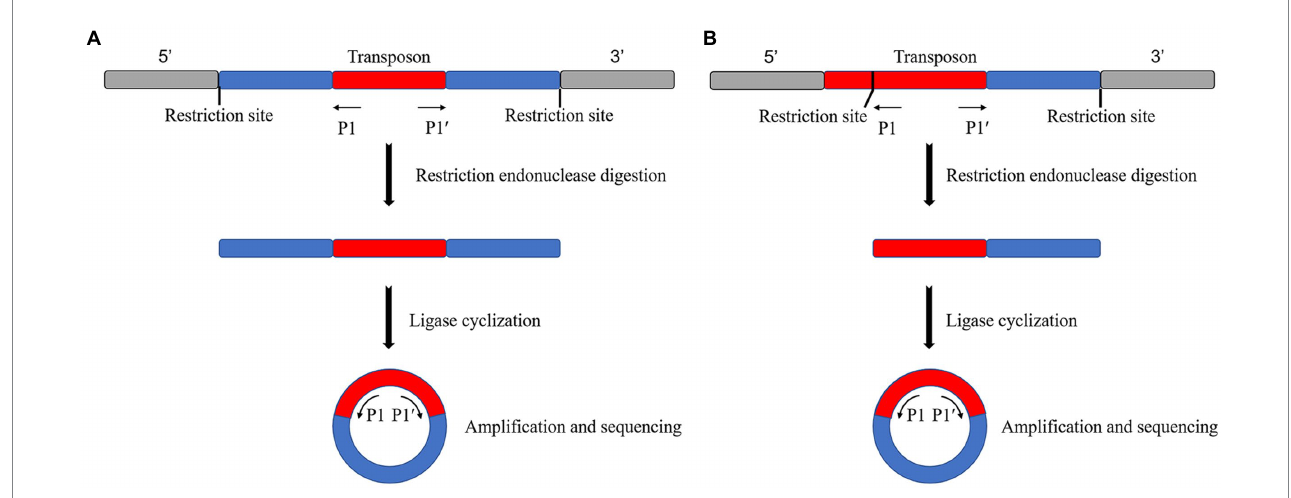
FIGURE 1 Schematic diagram of the reverse PCR principle. (A) No restriction endonuclease digestion site on the transposon, sequenced as both sides of the transposon insertion site after self-associative cyclization. (B) Single restriction endonuclease digestion site on transposon, sequenced as a unilateral sequence of the transposon insertion site after self-associative cyclization.